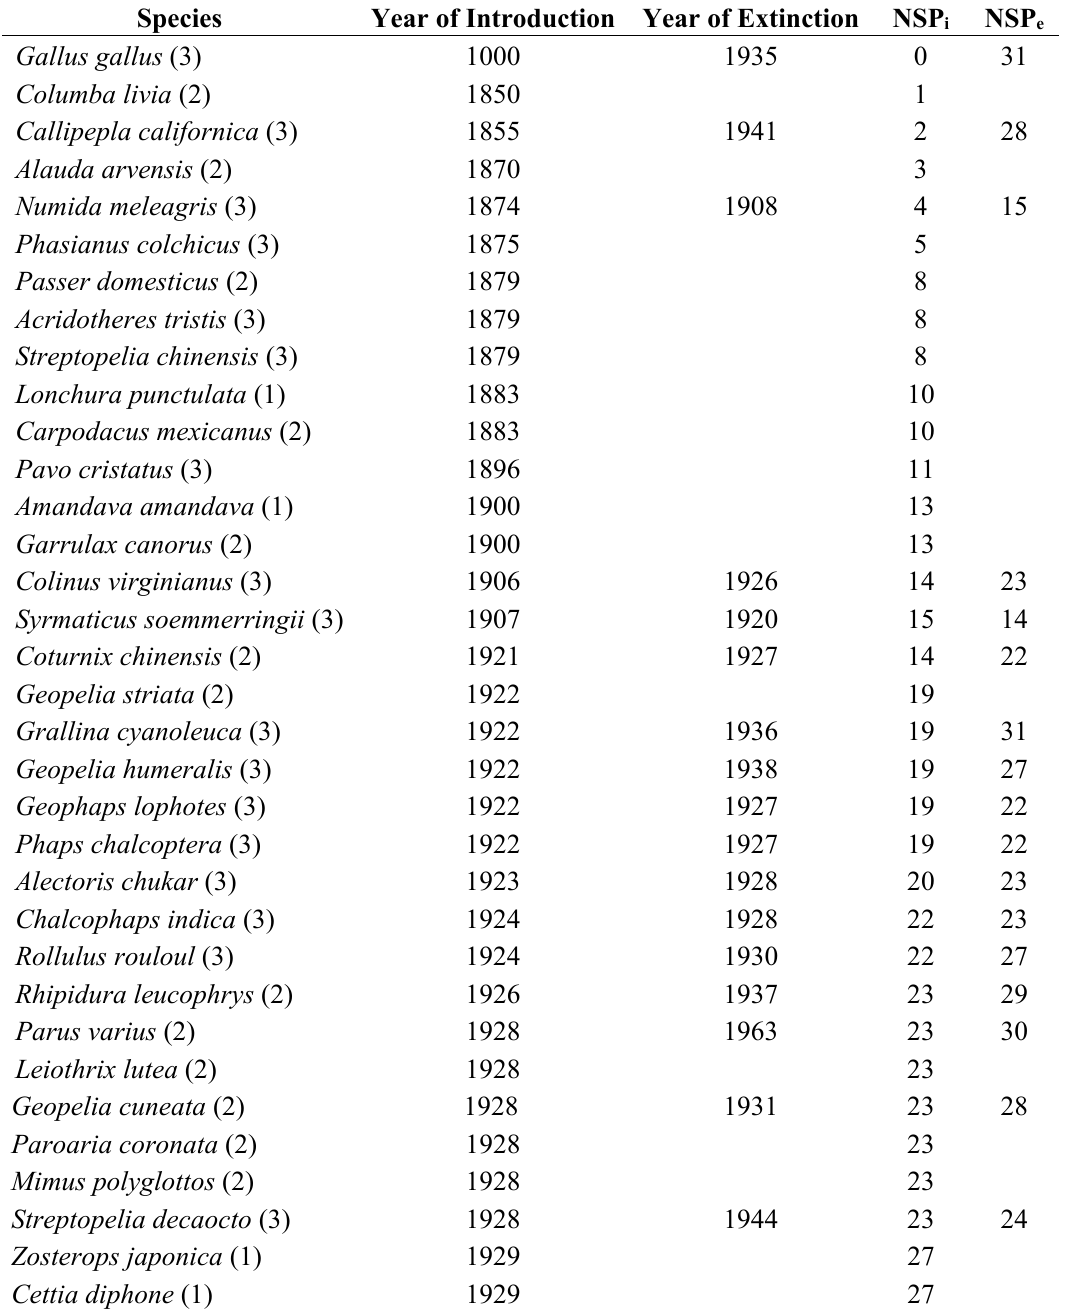
Table 1. Order and fate of introductions of birds introduced to Oahu. Numbers in parentheses after the birds’ names indicate membership of the body size group revealed by the discontinuity